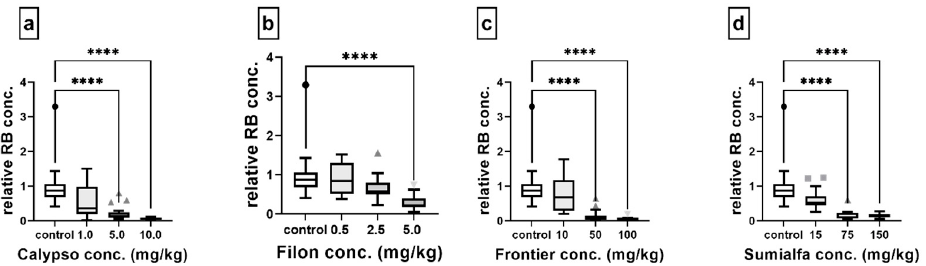
Figure 4. Results of MXR activity determination in E. andrei after 48-h pesticide exposures in soil. Relative rhodamine B (RB) concentrations for the determination of MXR activity after 48 h exposures to the investigated pesticide preparations ( a ) Calypso (active ingredient thiacloprid), ( b ) Sumialfa (active ingredient esfenvalerate), ( c ) Frontier (active ingredient dimethenamid-p), and ( d ) Filon (active ingredient prosulfocarb). Results are presented as mean ± standard deviation ( n = 20). Significant differences (**** p < 0.0001) between control and pesticide treatments are presented (ANOVA followed by Dunnett’s multiple comparison